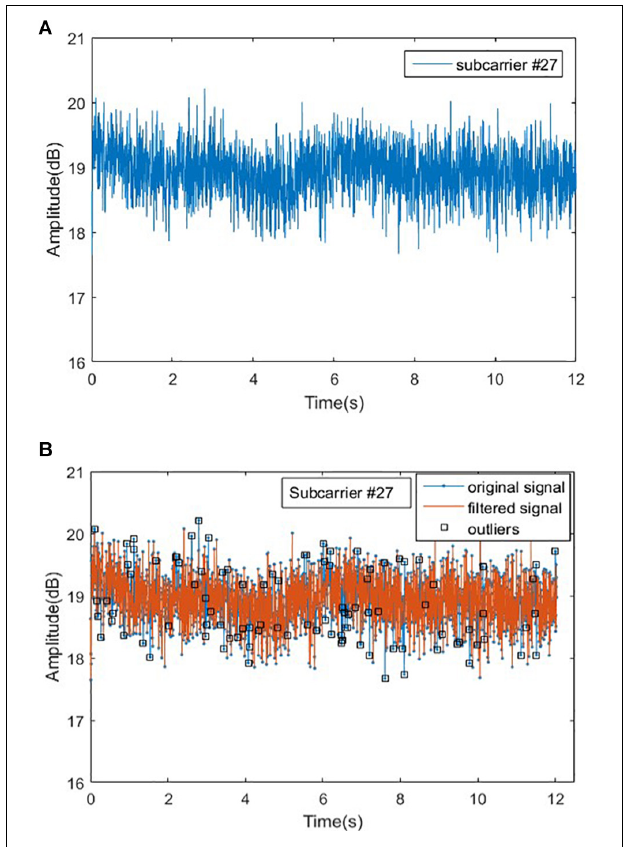
FIGURE 7 | Original signal and outliers for normal people in Romberg’s test. (A) Original signal for normal people and (B) outliers for normal